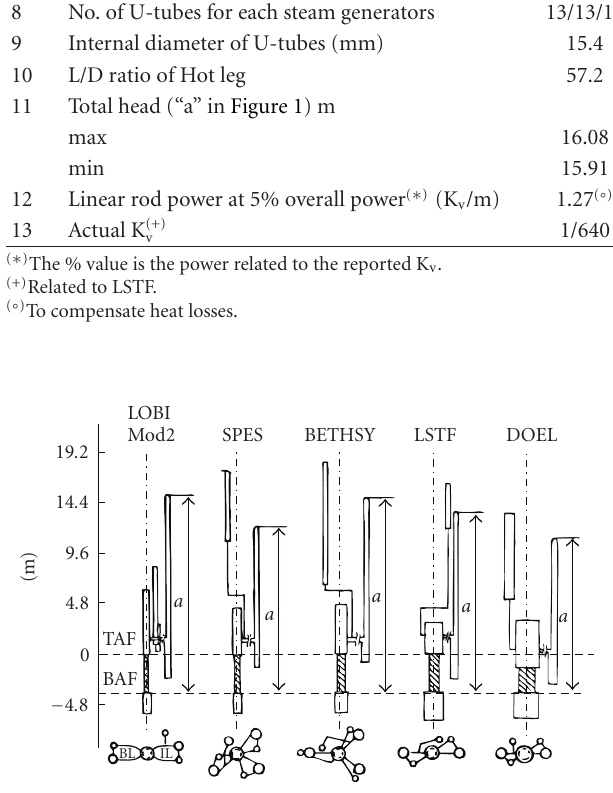
Figure 1: Sketch of the facilities considered for the experimental data base